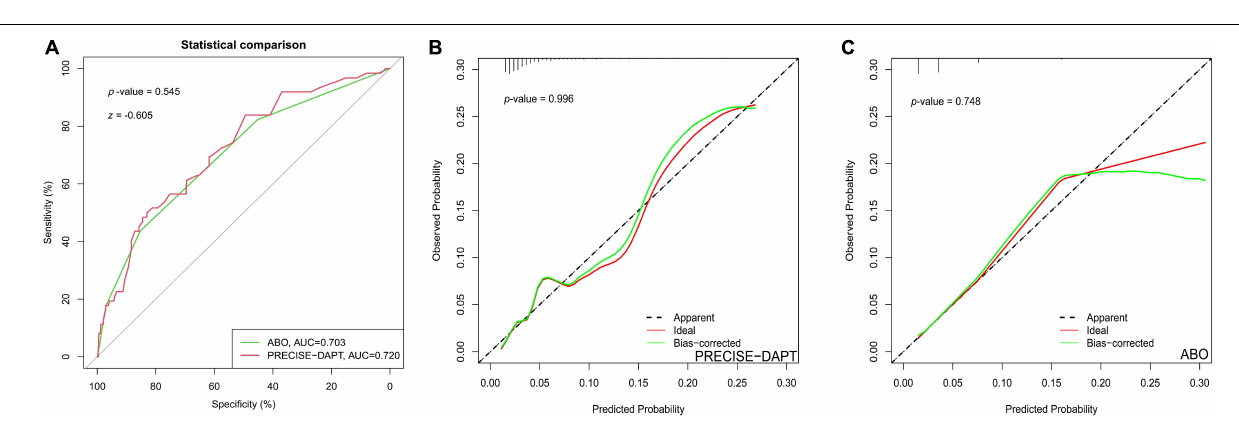
FIGURE 3 | The performance of ROC curve and calibration plot for PRECISE-DAPT and ABO risk score systems in ACS patients with 1-year DAPT after PCI. (A) ROC curve for the prediction of BARC ≥ 2 type bleeding events by PRECISE-DAPT and ABO risk score systems in ACS patients with 1-year DAPT after PCI [AUC: 0.720 and 0.703, respectively; (95% CI, 0.656–0.784) and (95% CI, 0.634–0.772), respectively; p < 0.001]. The C-statistics for the two risk models were compared to each other by the DeLong test ( z = –0.605, p = 0.545). (B) The calibration plot for the PRECISE-DAPT risk score in ACS patients (GOF Chi-square = 0.008, p -value = 0.996). (C) The calibration plot for the ABO risk score in ACS patients (GOF Chi-square = 0.580 p -value =